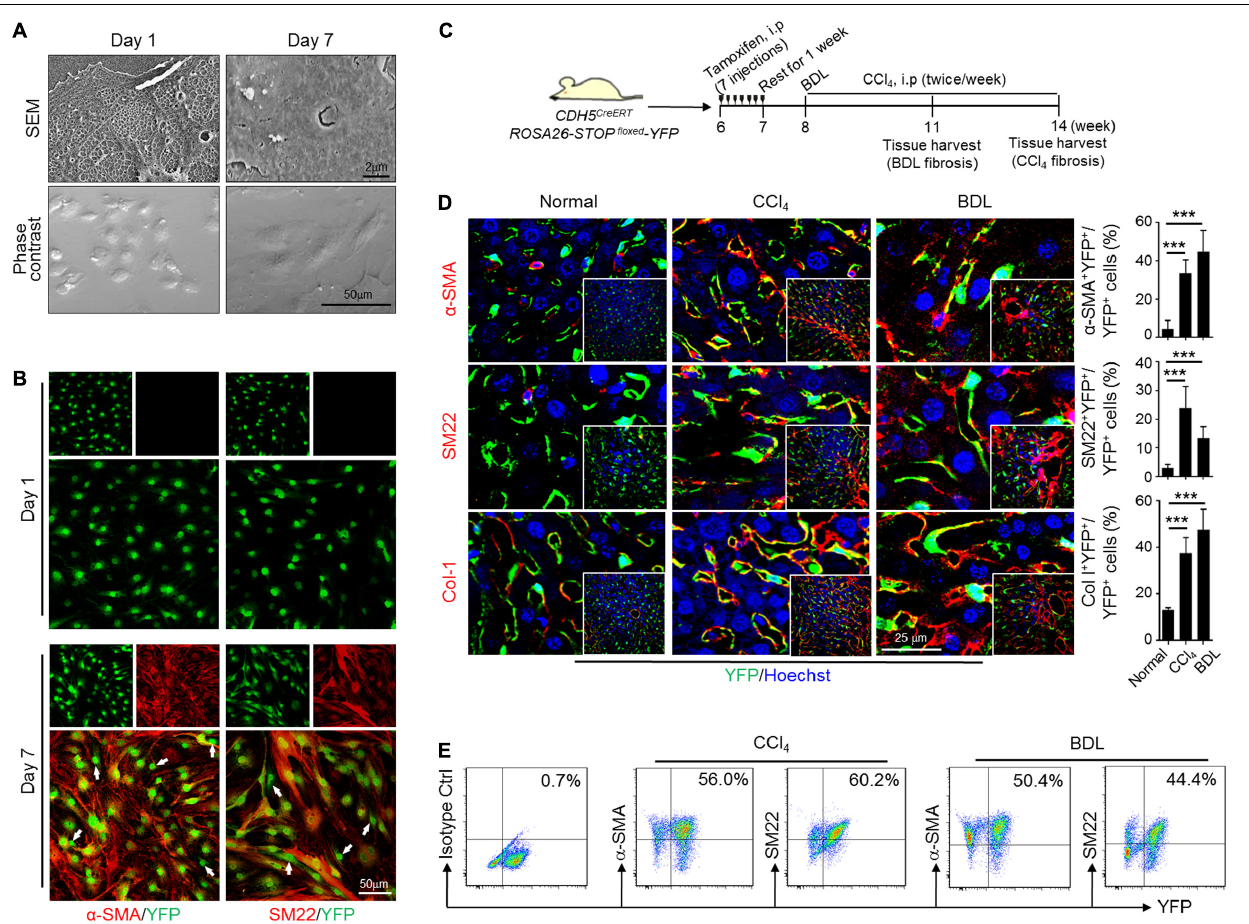
FIGURE 2 | Lineage tracing study verifies EndMT of LSECs in vitro and in vivo . (A,B) LSECs from genetically labeled EC YFP mice were cultured for indicated days, observed under an SEM (top) or a light microscope (phase contrast, bottom) and further counterstained with anti- α -SMA and anti-SM22 ( n = 3). Arrows indicate LSECs that are negative for α -SMA or SM22. (C) Strategy for establishing liver fibrosis models on EC YFP mice. (D) Liver cryosections from EC YFP mice subjected to CCl 4 - or BDL-fibrosis were stained for YFP plus α -SMA, SM22, or Col-1. The percentages of YFP + α -SMA + , YFP + SM22 + , and YFP + Col-1 + cells in total YFP + LSECs were quantitatively compared with the normal control ( n = 4 for the CCl 4 model and n = 5 for the BDL model). Bars = means ± SD; *** P < 0.001 vs. normal control, using two-tailed t -test. (E) LSECs were isolated from mice in (C), and analyzed by FACS for endogenous YFP and α -SMA/SM22 after cytoplasmic anti- α -SMA/anti-SM22